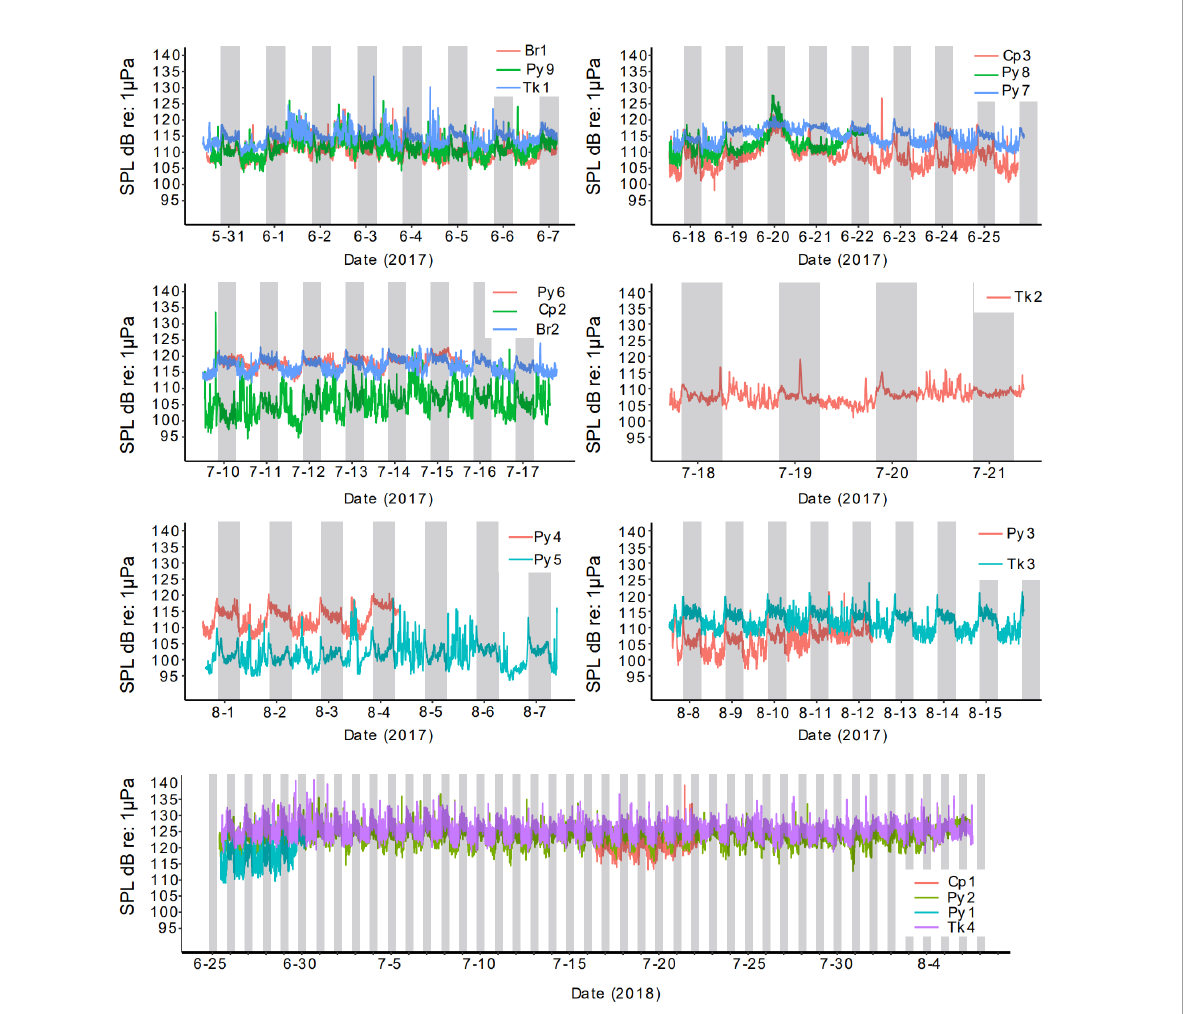
FIGURE 9 Sound intensity (SPL RMS dB re 1µPa) over time at arti fi cial reef study sites. Reefs recorded during the same period are shown on the same subplot. Gray bars indicate evening hours.